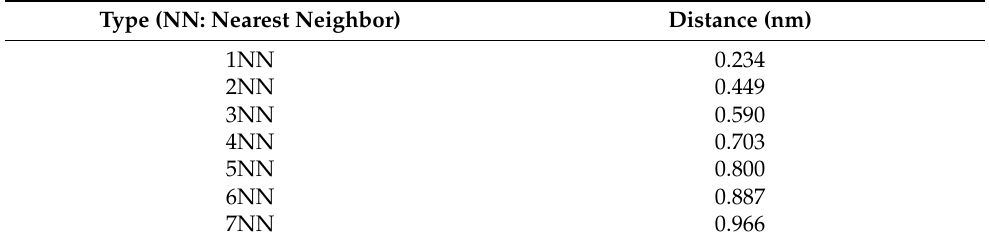
Table 2. Distance between the vacant site and oxygen atom for i NN Frenkel pairs ( i = 1, 2, . . . , 7). Type (NN: Nearest Neighbor)